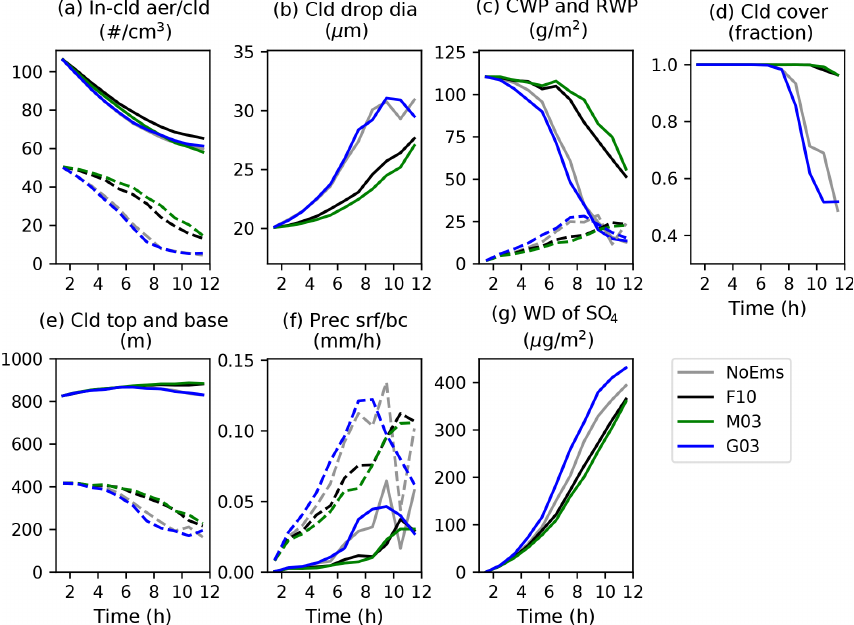
Figure 3. Impact of sea spray flux on the cloud layer for different emission parameterizations. Hourly averaged time series, mean over the model area. (a) In-cloud interstitial aerosol (solid) and cloud droplet (dashed) concentration, (b) cloud droplet size, mean over cloudy grid cells, (c) cloud liquid water path (solid) and rain water path (dashed), (d) cloud fraction, (e) height of cloud top (solid) and base (dashed), (f) precipitation rate at surface (solid) and below cloud (dashed), and (g) cumulative wet deposition of background aerosol (ammonium bisulfate). Simulations: grey – no-emission control, black – F10, blue – G03, green – M03 setups. All schemes were run with SST 10 ◦ C and 10ms − 1 wind speed. Grid cell is considered cloudy if cloud water mixing ratio exceeds 1 × 10 − 5 kgkg − 1 . All columns with at least one cloudy cell contribute to cloud